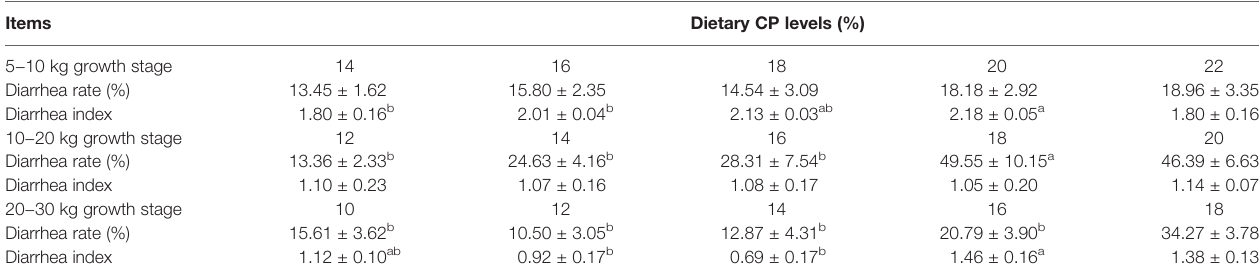
TABLE 1 | Effects of dietary crude protein (CP) levels on the diarrhea incidence of Huanjiang mini-pigs during different growth stages. Items Dietary CP levels (%)